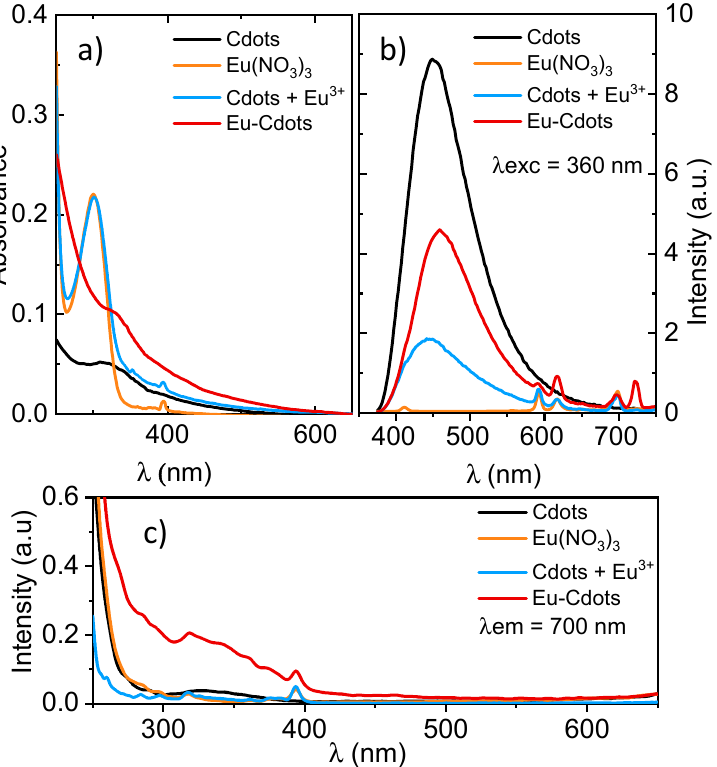
Figure 3. Optical properties of Cdots (black), Eu (NO 3 ) 3 (orange), a mixture of Cdots + Eu 3+ in water (blue) and Eu-Cdots (dark red); ( a ) absorption spectra, ( b ) photoluminescence emission spectra excited at 360 nm, and ( c ) photoluminescence excitation spectra collected at 700 nm. The absorption spectrum of Cdots (Figure 3a) shows a broad and relatively unstruc- tured absorption extending from the UV through the visible region with a characteristic shoulder ~350 nm with contributions from n– π * transition involving the O or N atoms of the functional groups of the Cdots and π – π * transition within the sp 2 core possibly involving interlayer charge transfer [41]. The UV-vis absorption spectrum of the Cdots + Eu 3+ mix- ture is the sum of the spectrum of the isolated Cdots and Eu (NO 3 ) 3 in aqueous